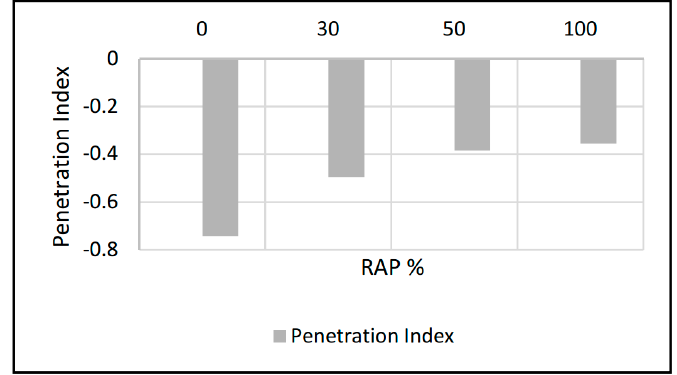
Figure 7. Penetration Index versus RAP content.